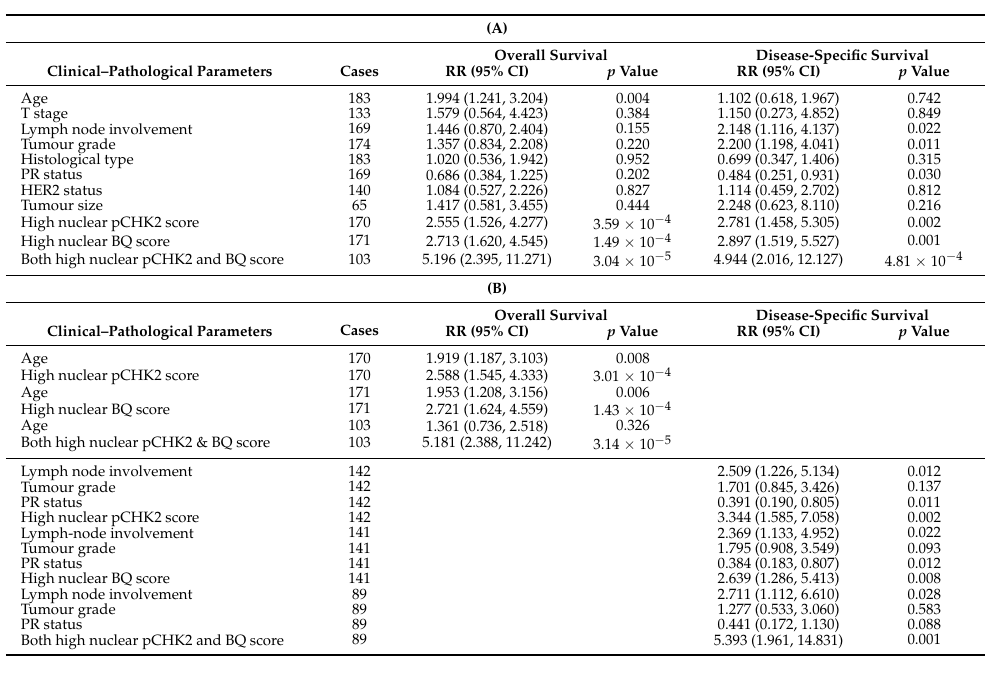
Table 1. ( A ) Univariate Cox regression analysis of overall and disease-specific survival in ER + ve breast cancer. ( B ) Multivariate Cox regression analysis of overall and disease-specific survival in ER + ve breast cancer.